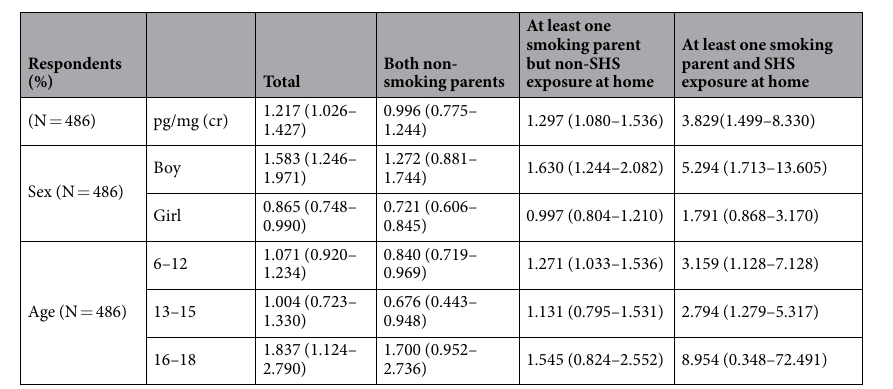
Table 3. Children’s urinary NNAL concentration according to parental smoking patterns. Geometric means and 95% CI. Creatinine-corrected